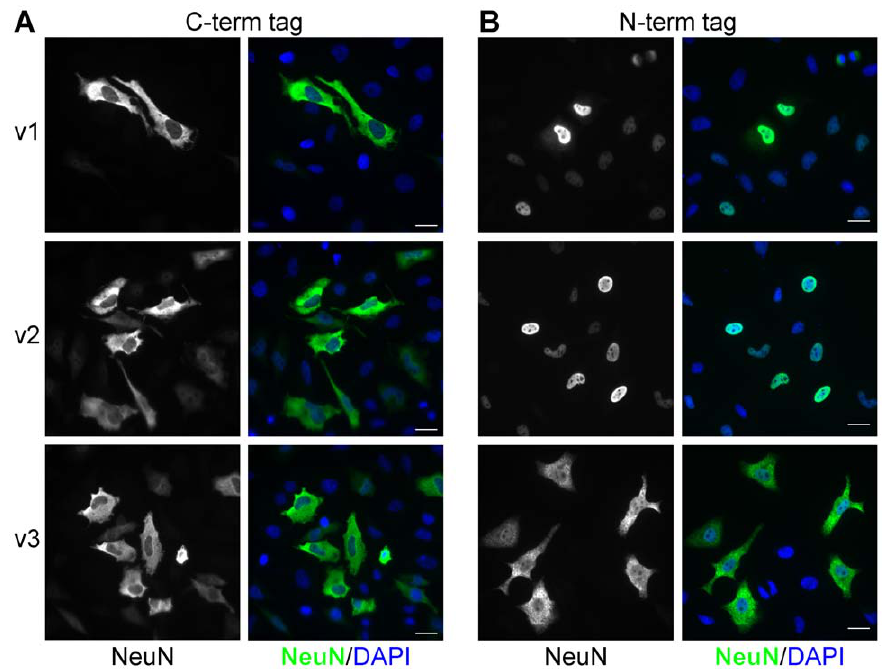
Figure 4. The C-terminus of Rbfox3 specifies sub-cellular location. Rbfox3 variants 1, 2 and 3 harboring C-terminal myc-tags (A), or N-terminal flag-tags (B) were expressed in HeLa cells and stained with anti-NeuN and DAPI. All C-terminally tagged proteins displayed predominantly cytoplasmic localization, whereas N-terminally tagged Fox3v1 and v2 displayed the expected nuclear localization. Scale bars indicate 50 m m.